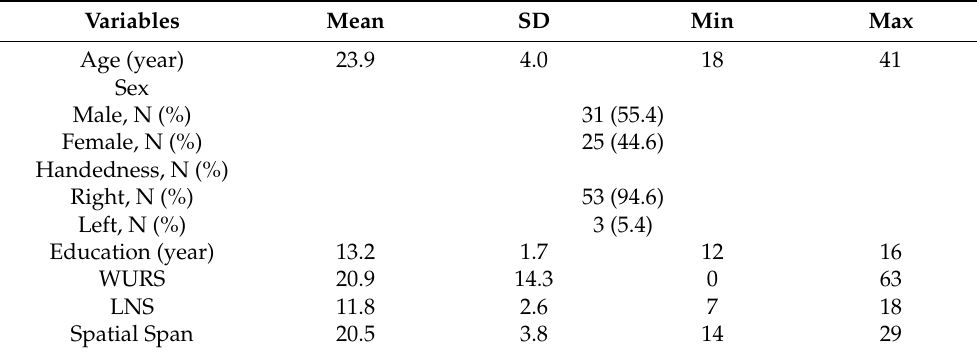
Table 1. Demographic and clinical characteristics of healthy